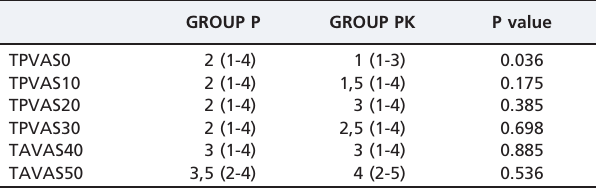
Table 4 - VAS values for tourniquet pain (TPVAS) (median, minimum-maximum).